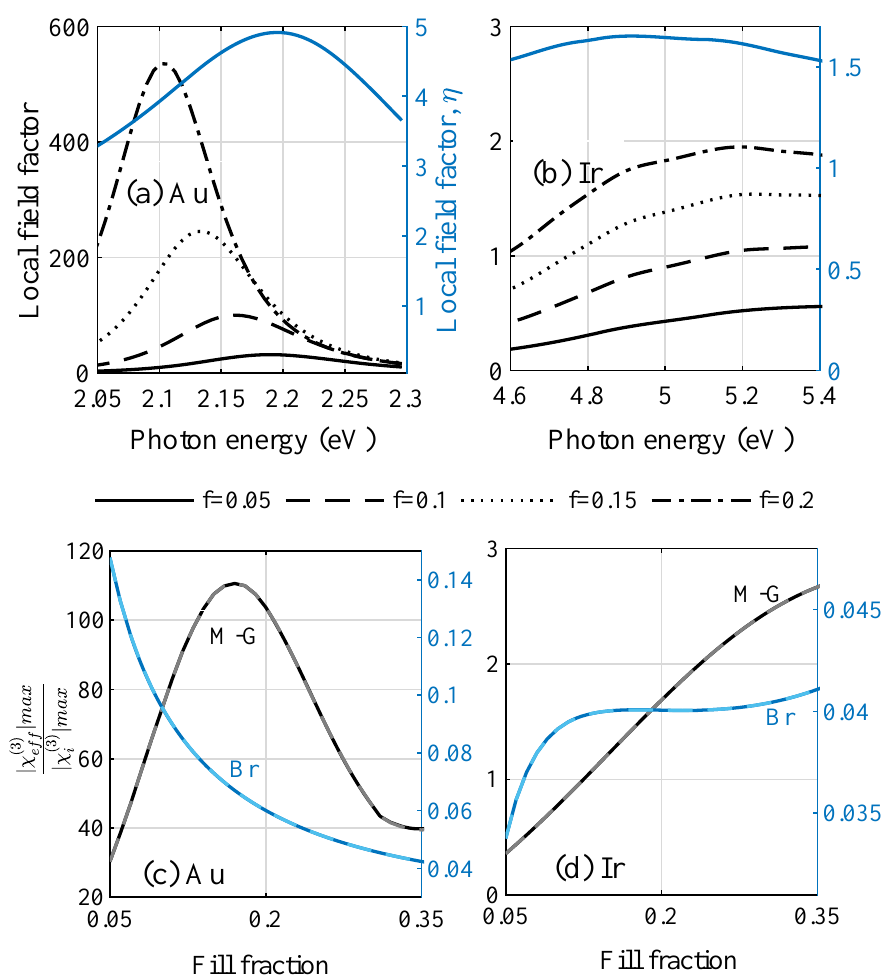
Figure 3. Absolute values of the ( a , b ) local field enhancement factors for ( a ) gold and ( b ) iridium in the Maxwell–Garnett theory for the nonlinear coefficients compared to the single particle enhancement factor | η | in the linear case. ( c , d ) Enhancement of the nonlinear coefficient comparing the amorphous structures relative to the bulk case for increasing fill factors f for both effective medium theories discussed (M-G grey, Br blue), comparing the prediction from Miller’s rule (light color) with the one fitted to experimental values (dark